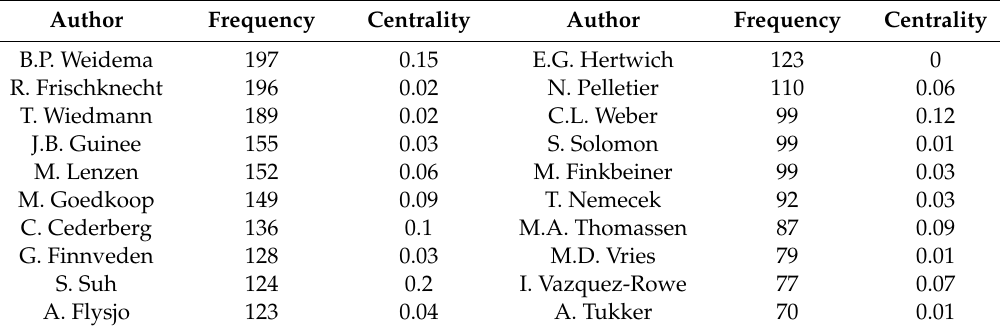
Table 5. Top 20 personal authors based on cited frequency.